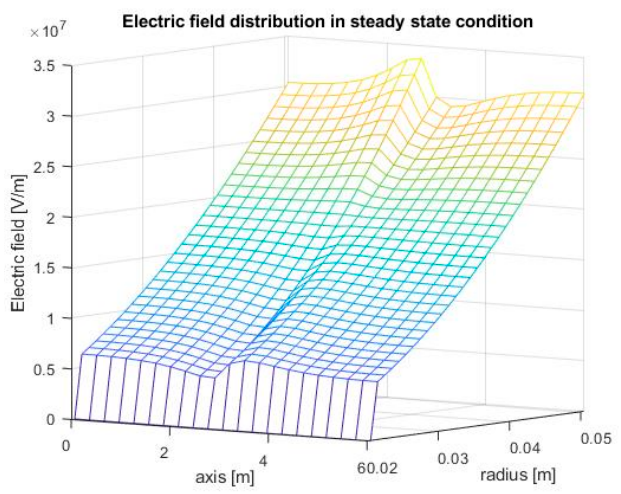
Figure 7. Electric field vs. radius and axis in steady state conditions—Scenario E.